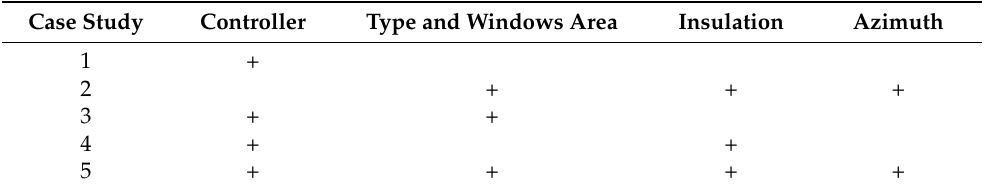
Table 3. Optimization